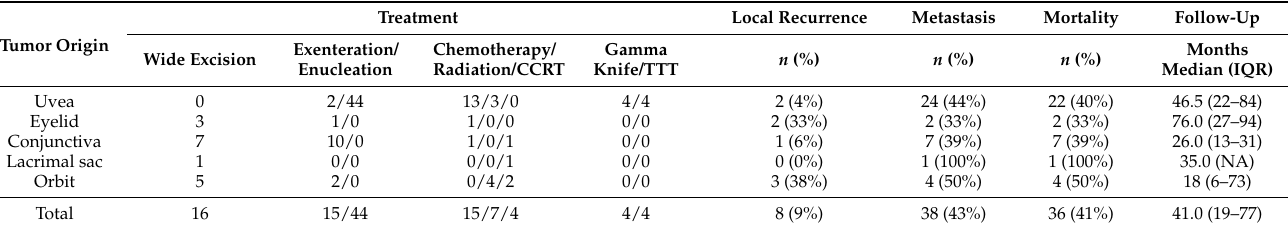
Table 2. Treatment modalities and outcomes of ocular melanoma.